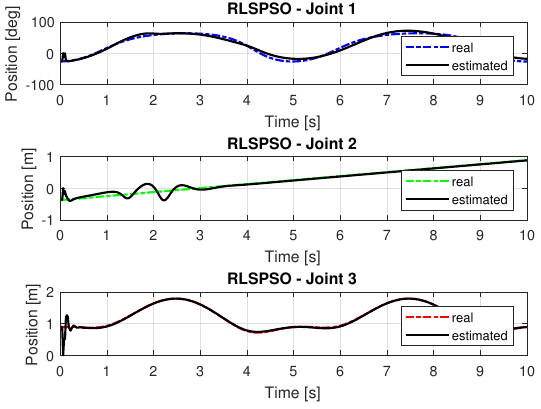
Figure 17. Trajectory in the joint space identified with RLSPSO.